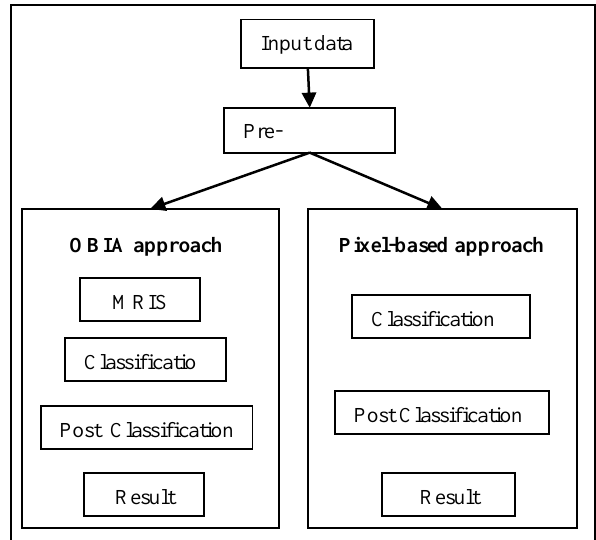
Figure 1. Flow chart of Object based approach and